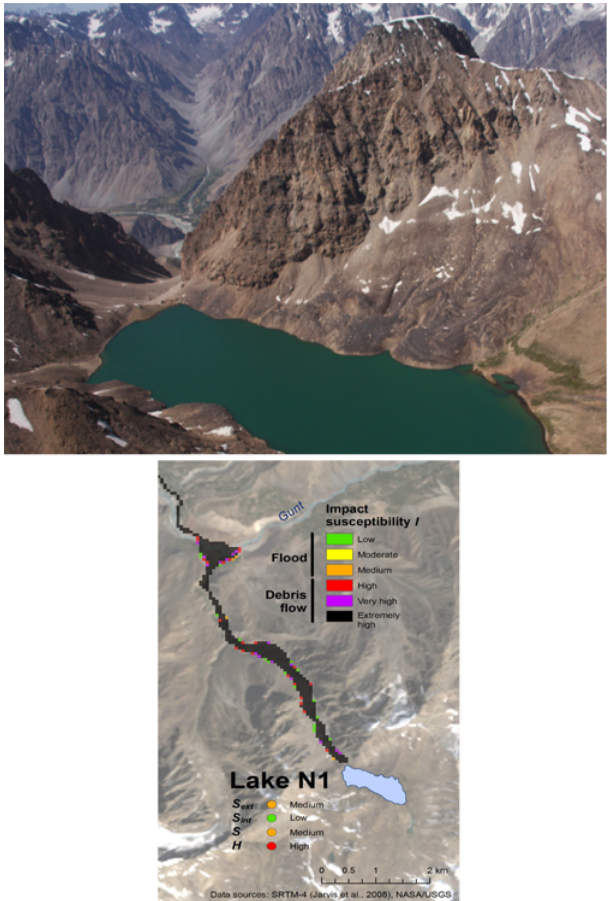
Fig. 11. (a) Aerial view of Lake N1 (Nimatskul) in August 2009, the Gunt Valley in the background. The viscous creep into the lake indicates that also the above rock wall is influenced by permafrost. (b) Modelled impact susceptibility I of a potential outburst of Ni-